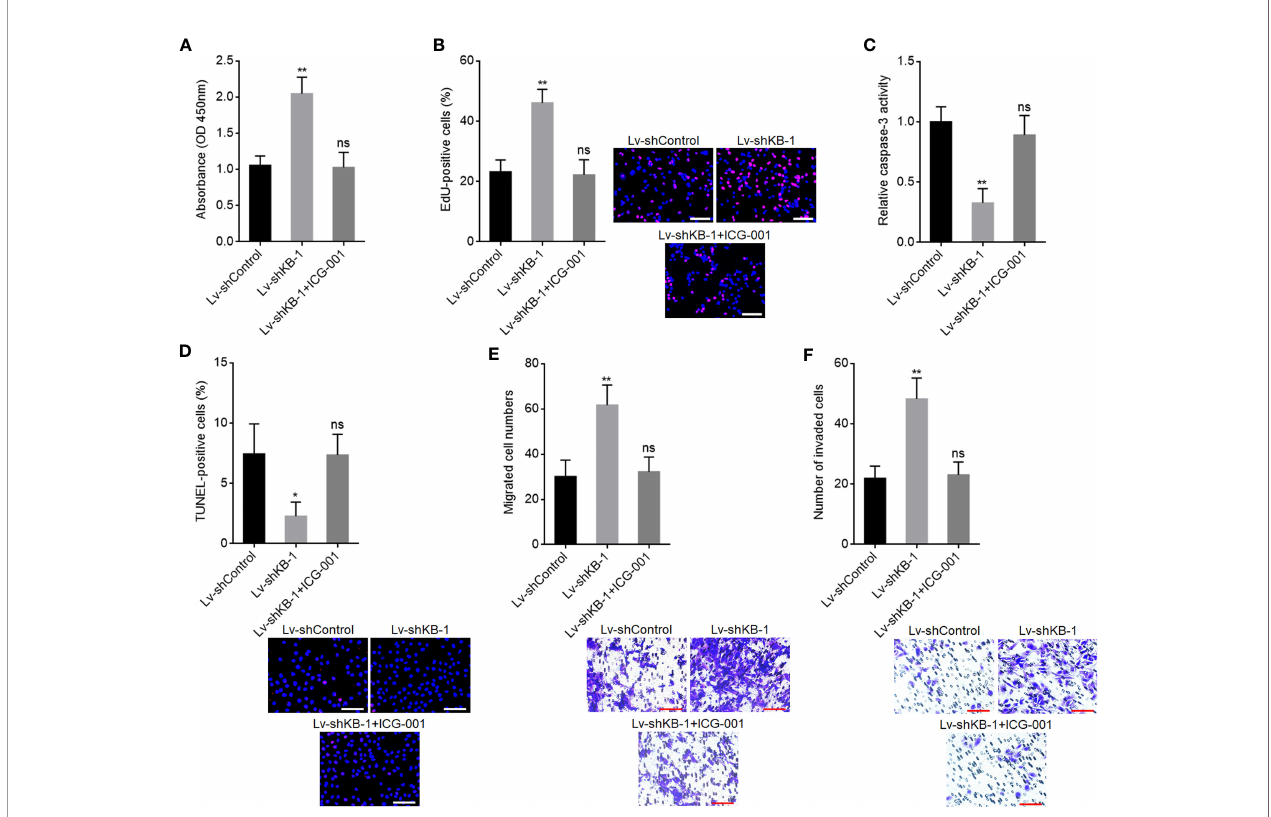
FIGURE 9 | Wnt/ b -catenin signalling inhibitor ICG-001 reversed the oncogenic roles of KB-68A7.1 depletion in HCC. (A) Cellular proliferation of KB-68A7.1 silenced SK-HEP-1 cells treated with 5 m M ICG-001 was measured by CCK-8 assay. (B) Cellular proliferation of KB-68A7.1 silenced SK-HEP-1 cells treated with 5 m M ICG- 001 was measured by EdU incorporation assay. Red colour indicates EdU-positive and proliferative cells. Scale bars = 100 µm. (C) Cellular apoptosis of KB-68A7.1- silenced SK-HEP-1 cells treated with 5 m M ICG-001 was measured by caspase-3 activity assay. (D) Cellular apoptosis of KB-68A7.1-silenced SK-HEP-1 cells treated with 5 m M ICG-001 was measured by TUNEL assay. Red colour indicates TUNEL-positive and apoptotic cells. Scale bars = 100 µm. (E) Cellular migration of KB-68A7.1-silenced SK-HEP-1 cells treated with 5 m M ICG-001 was measured by Transwell migration assay. Scale bars = 100 µm. (F) Cell invasion of KB-68A7.1- silenced SK-HEP-1 cells treated with 5 m M ICG-001 measured by Transwell invasion assay. Scale bars = 100 µm. Results are shown as mean ± SD based on three independent experiments. *p < 0.05, **p < 0.01, ns, not signi fi cant by one-way ANOVA followed by Dunnett ’ s multiple comparisons